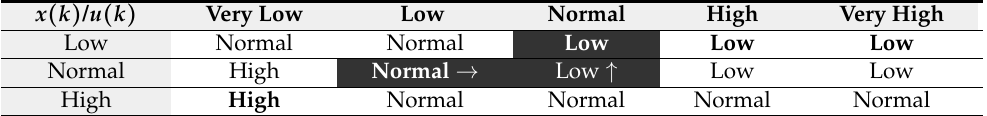
Table 4. Example of stable transition for a component of the vector of emotions x ( k + 1 ) (function g ). The gray cells represent the different input and states allowed by the